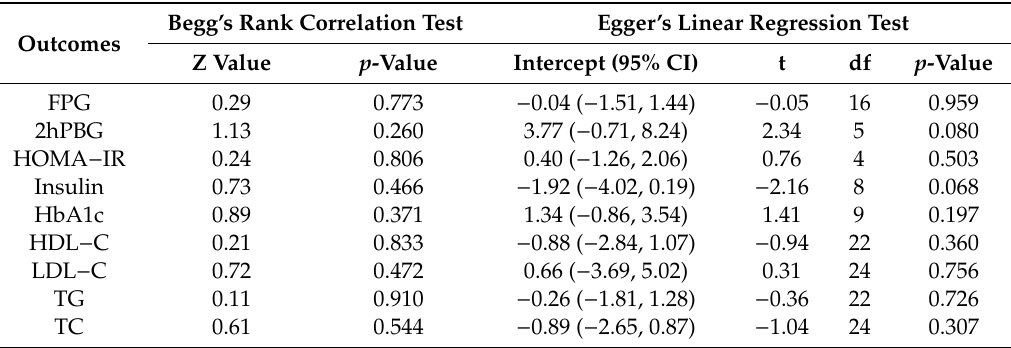
Table 3. Publication bias in the meta-analysis of